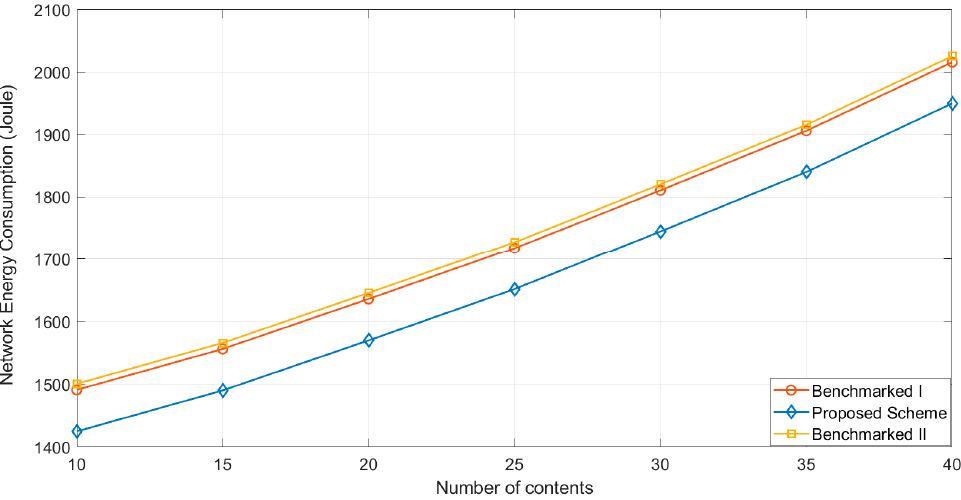
Figure 10. UAV energy consumption V/S number of contents.